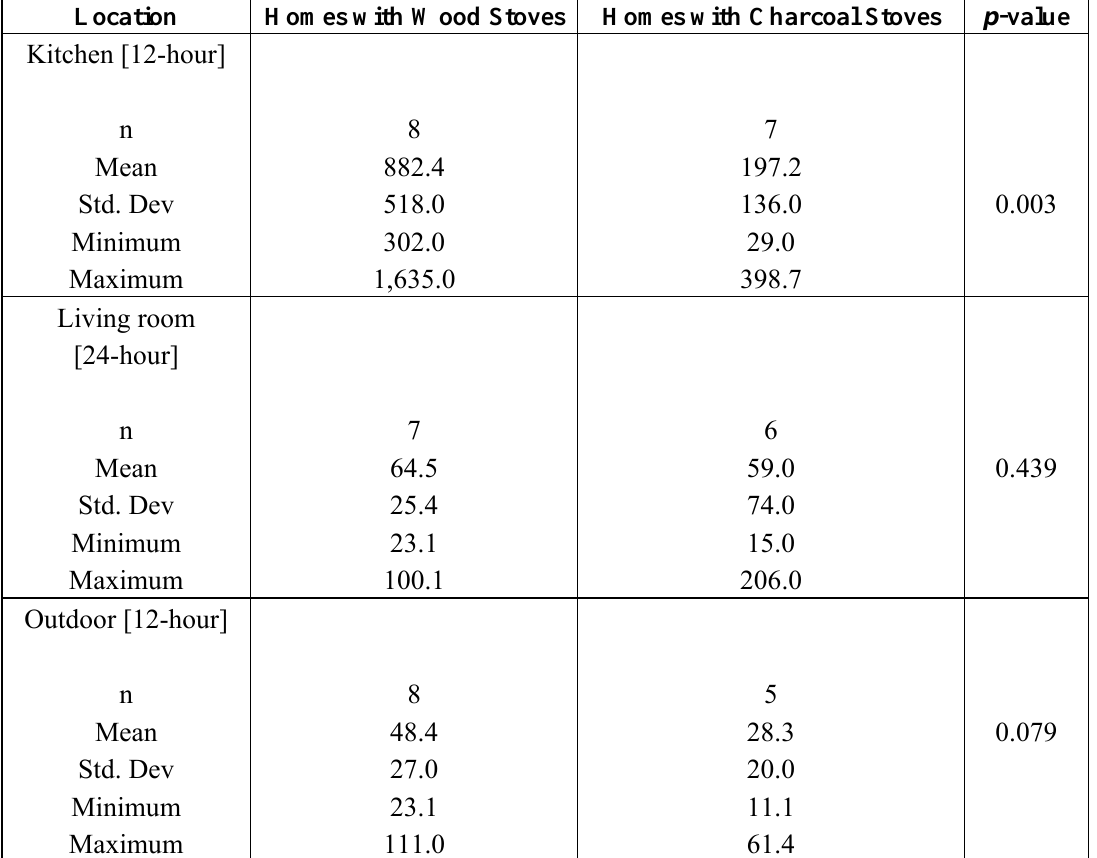
Table 5. SPM levels in count per minute (CPM) in three different locations.